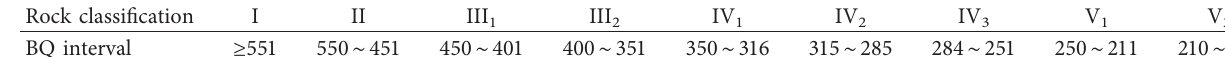
Table 3: Subclassification criteria of rock mass around tunnels.